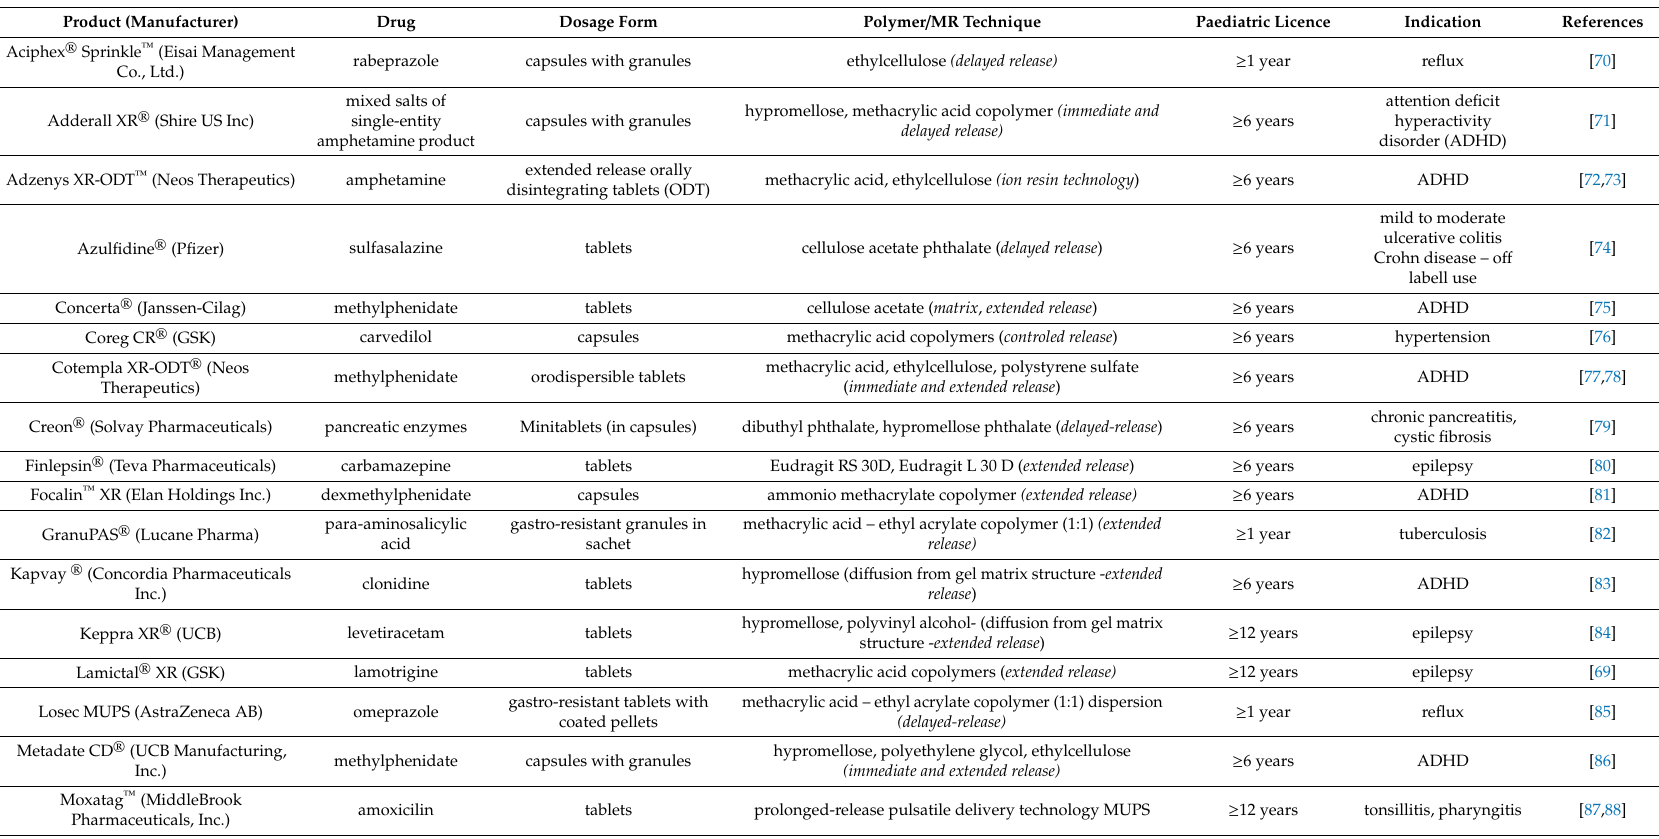
Table 2. Modified release solid dosage forms—an overview of available formulations with paediatric